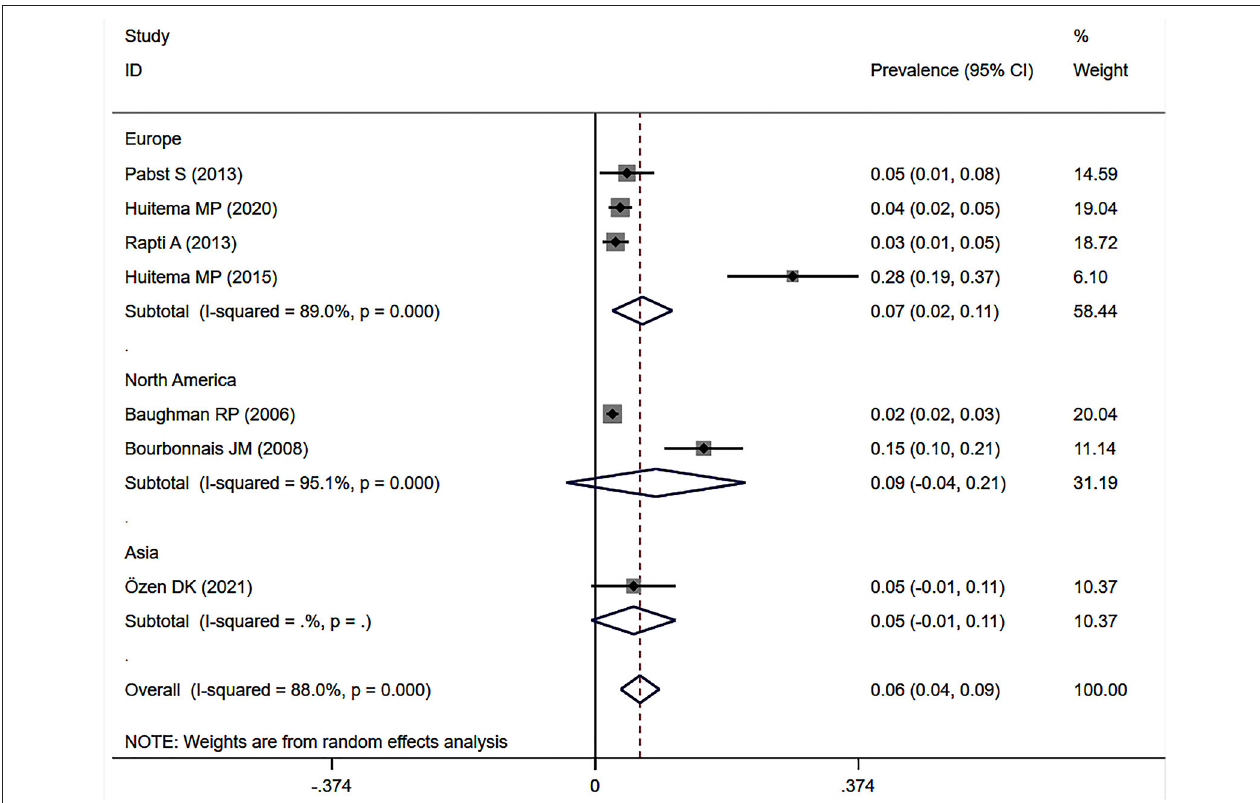
FIGURE 5 | Subgroup analysis of the prevalence of SAPH by RHC in the general sarcoidosis population by geographical regions. SAPH, sarcoidosis-associated pulmonary hypertension; RHC, right heart